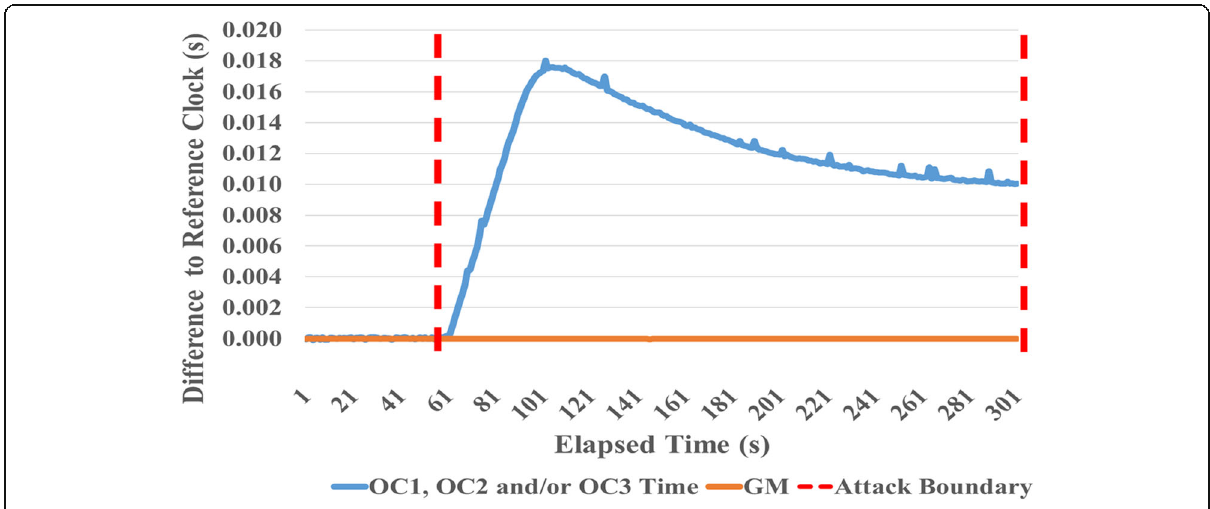
Fig. 6 Impact of asymmetric packet delay manipulation